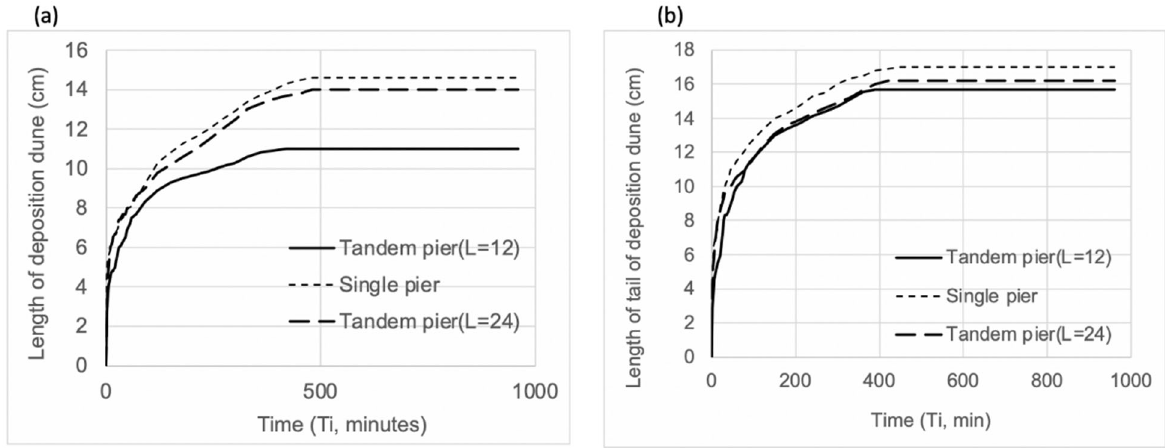
Figure 7. ( a ) Variations in the length of deposition dune downstream of rear pier; ( b ) the length of tail of deposition dune downstream of rear pier. ( H = 10 cm, V = 0.2 m/s).